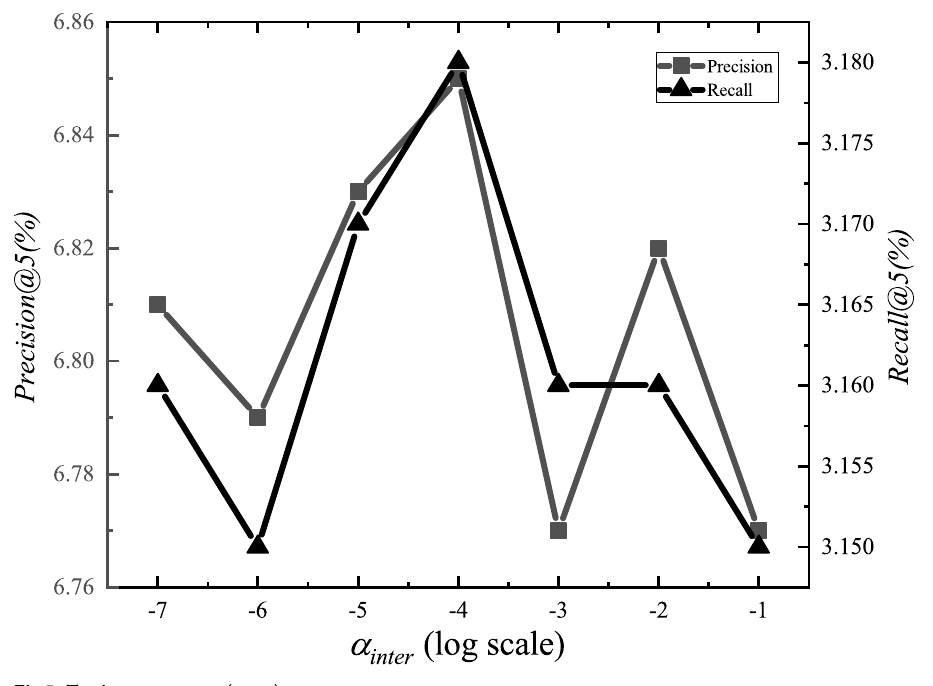
Fig 5. Tuning parameters( α inter ).